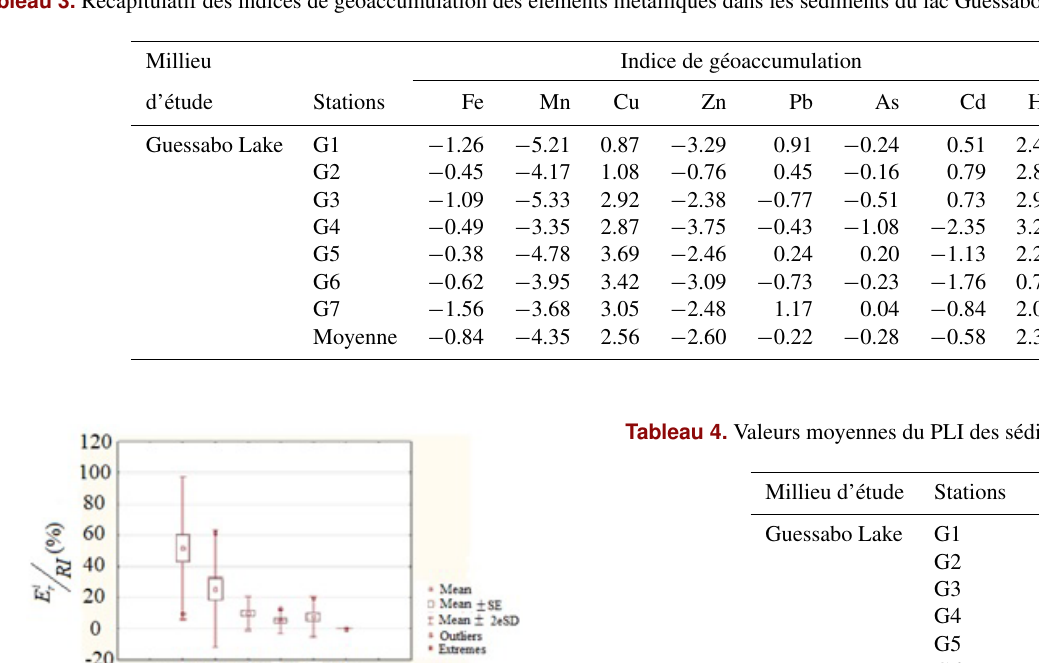
Tableau 3. Récapitulatif des indices de géoaccumulation des éléments métalliques dans les sédiments du lac Guessabo.